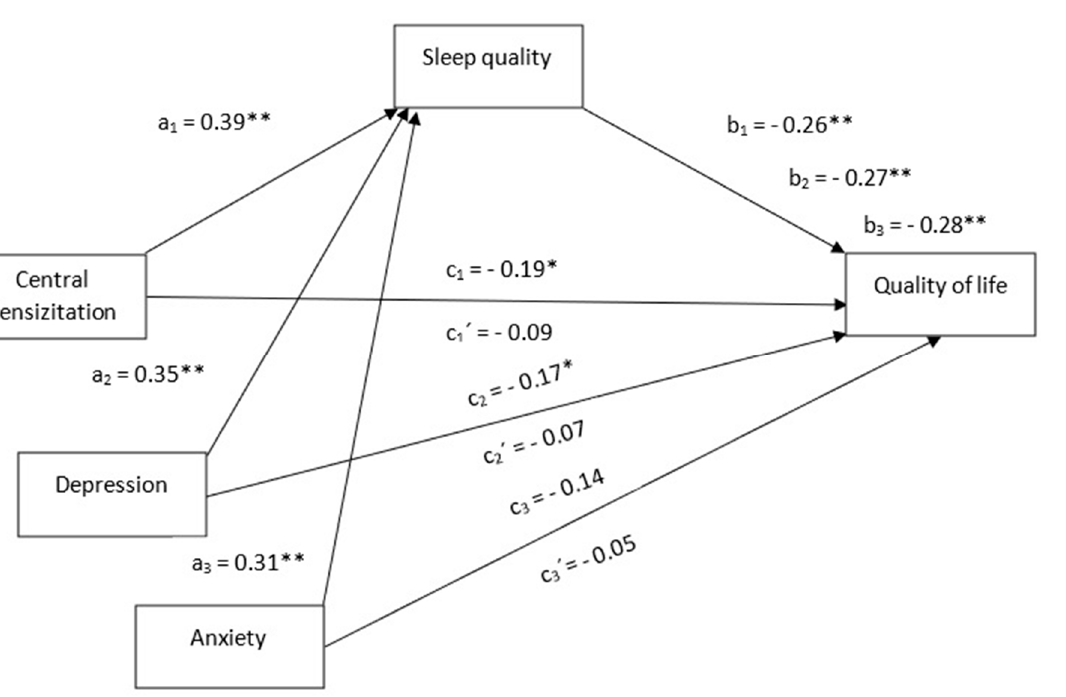
effect, the direct effect, and the indirect effect with 5.000 resamples and bias-corrected